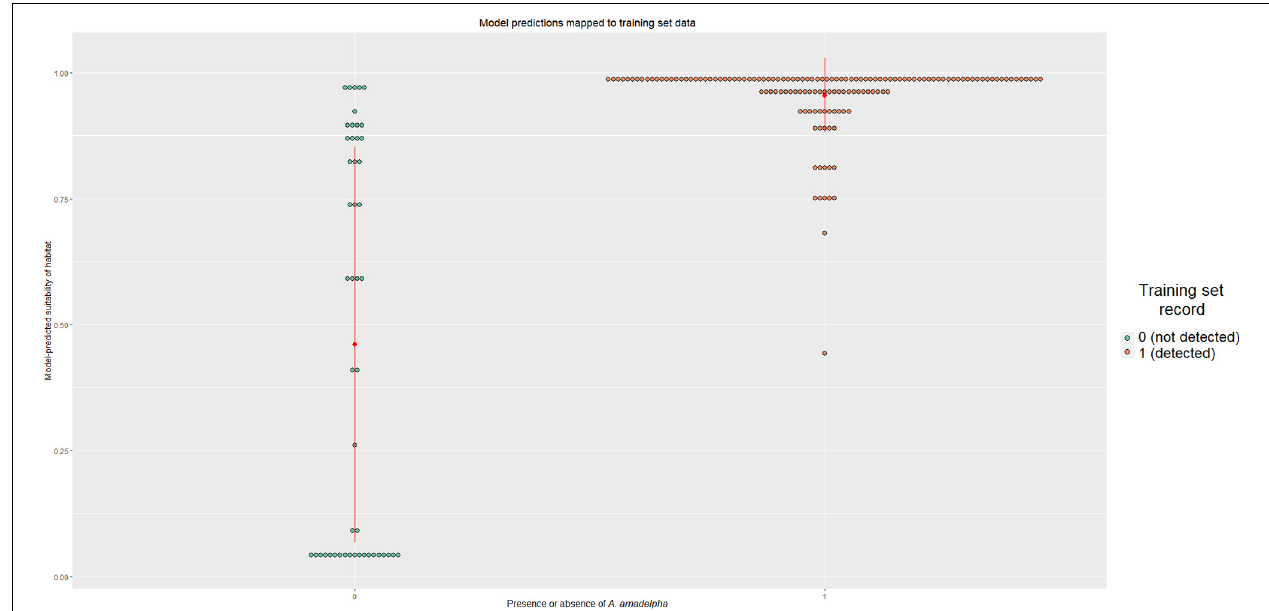
FIGURE 3 | Dotplot showing the spread of model predictions compared to known observations of A. amadelpha presence or absence. The category mean is indicated by a red dot; the vertical lines extending from the mean indicate the standard deviation of that category.